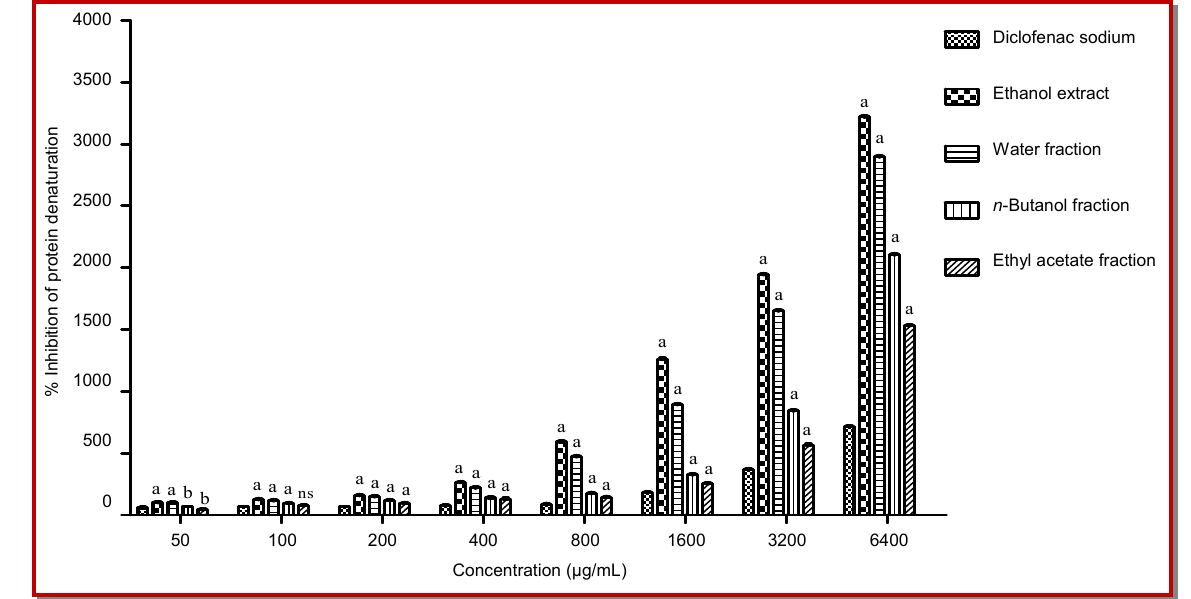
Figure 1: Effect of E. gerardiana on inhibition of protein (egg albumin) denaturation. Results are expressed as mean ± SEM (n=3), using two way ANOVA followed by Bonferroni posttest. a p<0.001, b p< 0.05 when compared to